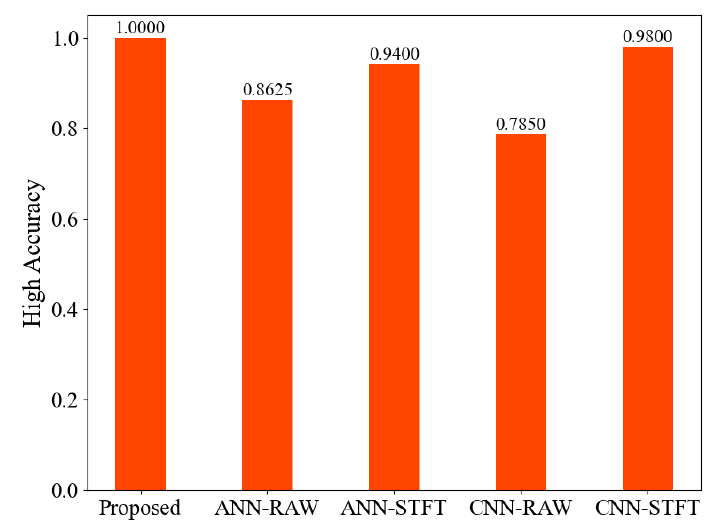
Figure 14. The highest classification accuracy between proposed and compared methods on DUT